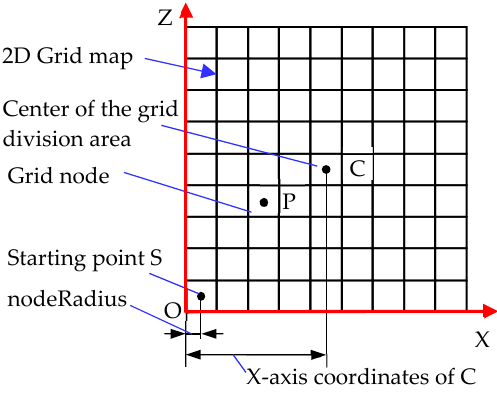
Figure 17. Schematic diagram of the dividing grid.